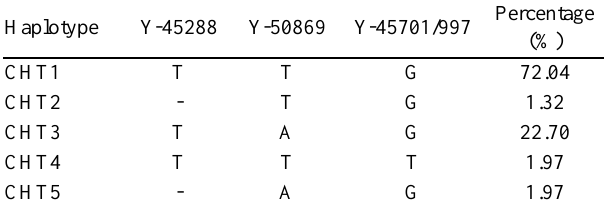
Table 4. The five haplotypes based on three Y chromosme loci Haplotype